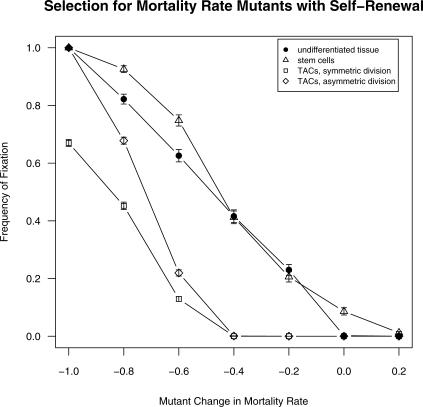
Frequency of Fixation by Mutations Affecting Cell Mortality in Nondifferentiating Populations, Under Serial Differentiation with Self-Renewal for Stem Cells, Transient Amplifying Stages Dividing Symmetrically, and Transient Amplifying Stages Dividing AsymmetricallyEach data point represents 500 trials with standard error bars. Cells that cannot apoptose (mortality change = −1.0) may still differentiate into the fully differentiated stage and stop dividing. Nondifferentiating populations, filled circles; serial differentiation with self-renewal for stem cells, triangles; transient amplifying stages dividing symmetrically, squares; transient amplifying stages dividing asymmetrically, diamonds.